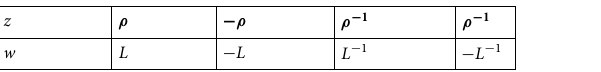
Table 2. Vertices correspondence for the conformal map of the upper half of the annulus ρ < upper half of the w -plane including the